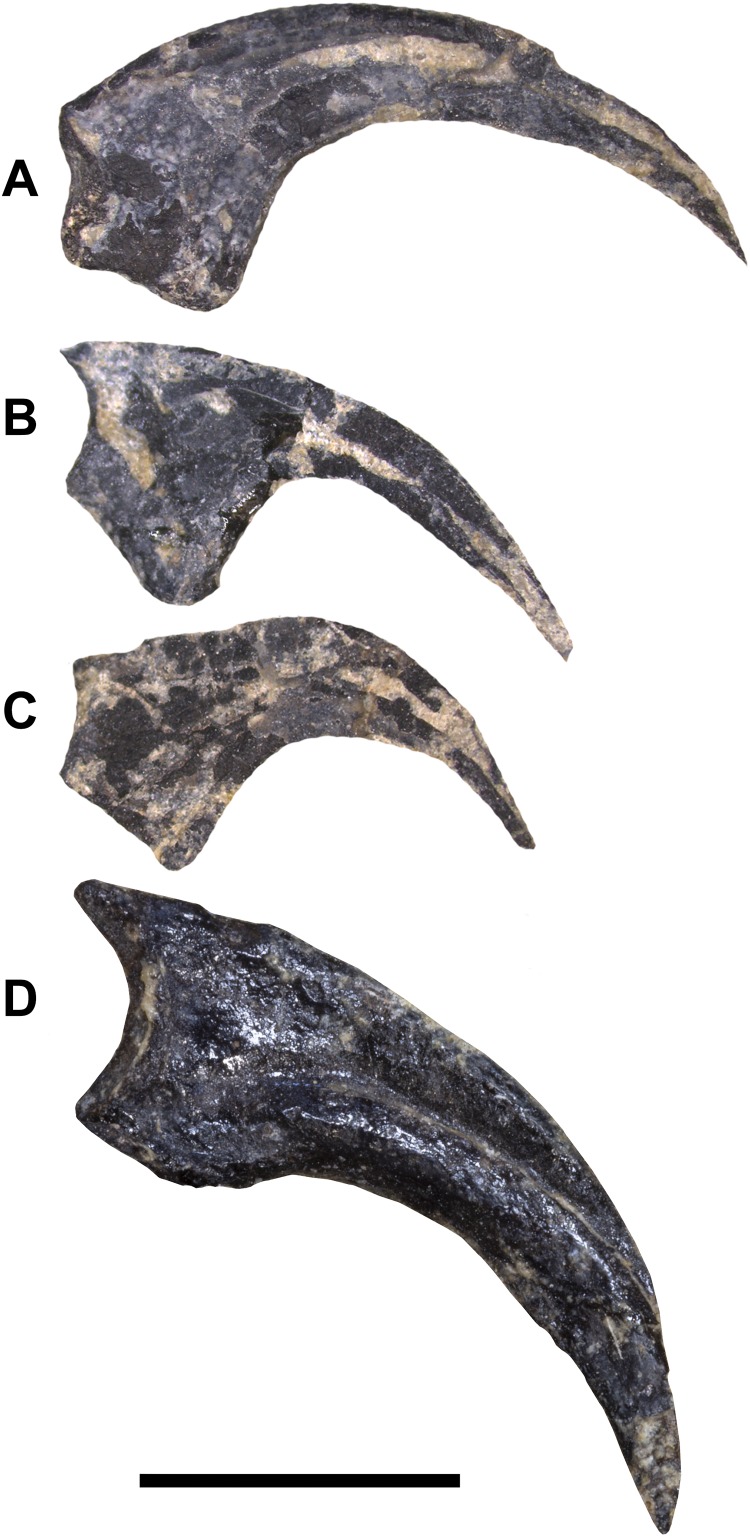
Unguals of WYDICE-DML-001.(A) Left manus ungual I in medial view. (B) Left manus ungual II in medial view. (C) Left manus ungual III in medial view. (D) Pedal ungual II (mirrored for ease of comparison) with trenchant sickle morphology. Scale bar = one cm.